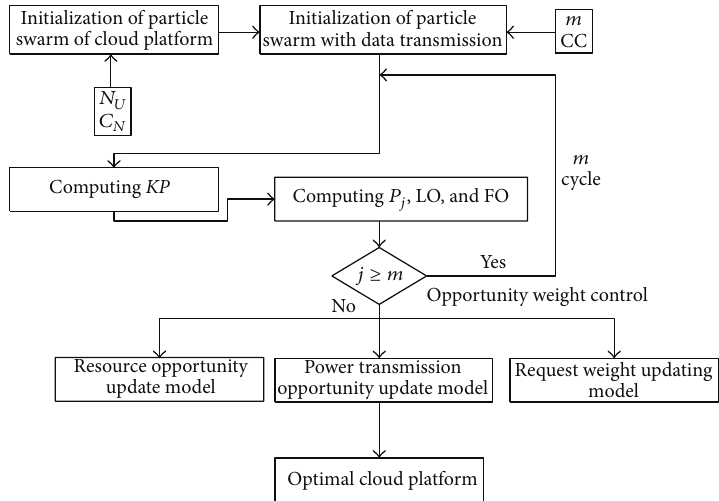
Figure 3: Flow of the weight particle swarm optimization algorithm.